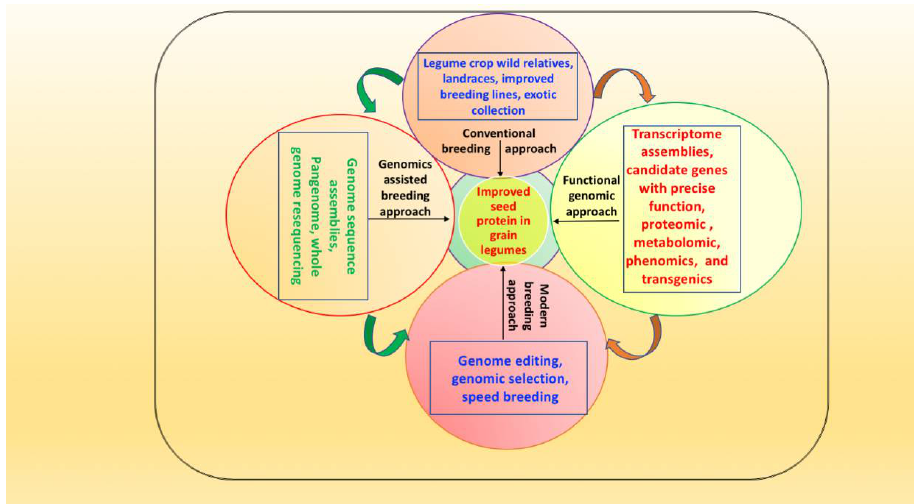
Figure 1. Integrated ‘omics’ and emerging novel breeding approach for improving protein content in grain legumes.